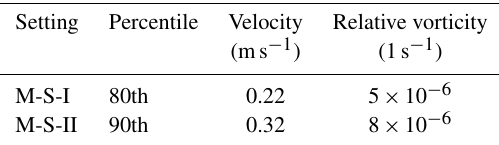
Figure 7. Mean surface kinetic energy of experiments with full-field 0.5 ◦ (L, thin black line), a spin-off full-field 0.1 ◦ (M, thick black line) since year 51, and two spin-off 0.5–0.1 ◦ regional refinement experiments (L-M-I and L-M-II, in blue and red lines, respectively). Table 2. Threshold values of surface velocity and surface relative vorticity (both in magnitude) for adaptive refinement from 0.1 to 0.02 ◦ . Two settings are chosen, corresponding to the 80th and 90th percentile of the two parameters, based on the full-field 0.1 ◦ exper-